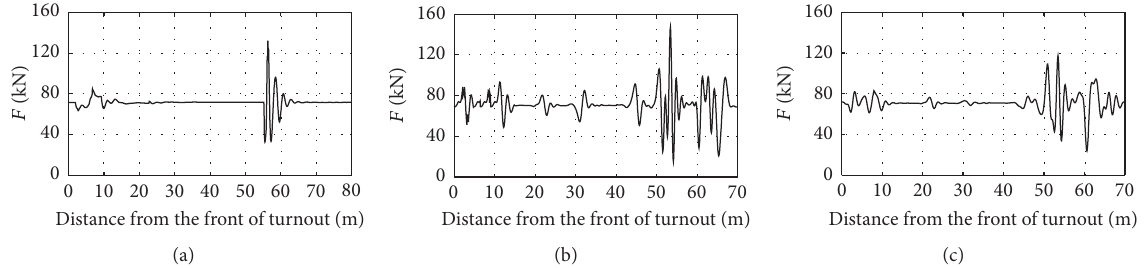
Figure 10: Wheel-rail vertical forces ((a) track stiffness neglected; (b) original track stiffness; (c) optimised track stiffness).